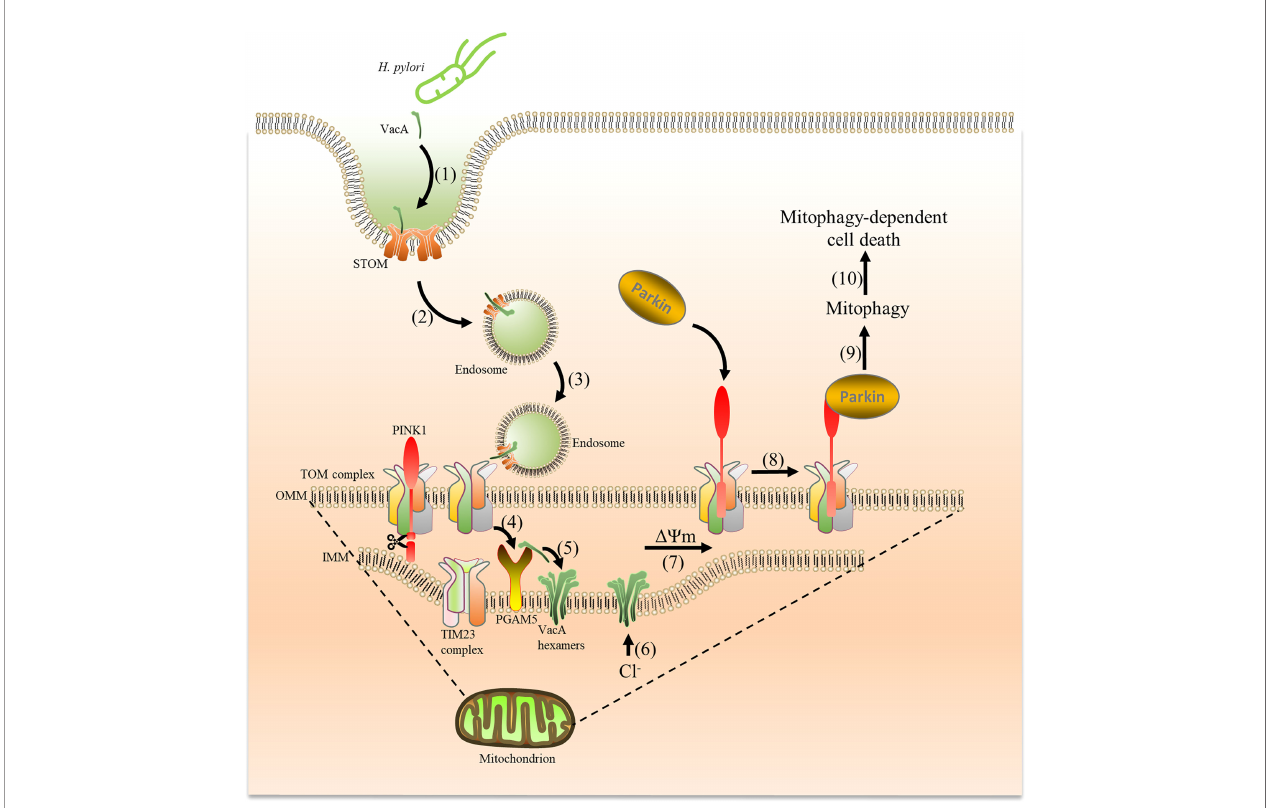
FIGURE 9 | VacA secreted by H. pylori is captured by cells and targets mitochondria, which induces mitophagy. Acid-activated VacA is fi rst captured by STOM on the cell membrane (1), and then forms endosomes to enter cells (2) and target mitochondria (3). VacA binds to the TOM complex (translocase of the outer membrane) and is transported into the mitochondrial membrane space (4). Subsequently, PGAM5 (on the inner mitochondrial membrane) binds to VacA and aids in inserting VacA into the inner mitochondrial membrane (5) to form Cl − channels (6). The imbalance of Cl - reduces the membrane potential (7), promoting PINK1 accumulation and Parkin recruitment from the cytosol to mitochondria to induce mitophagy (8) (9),. Mitophagy eventually leads to cell death